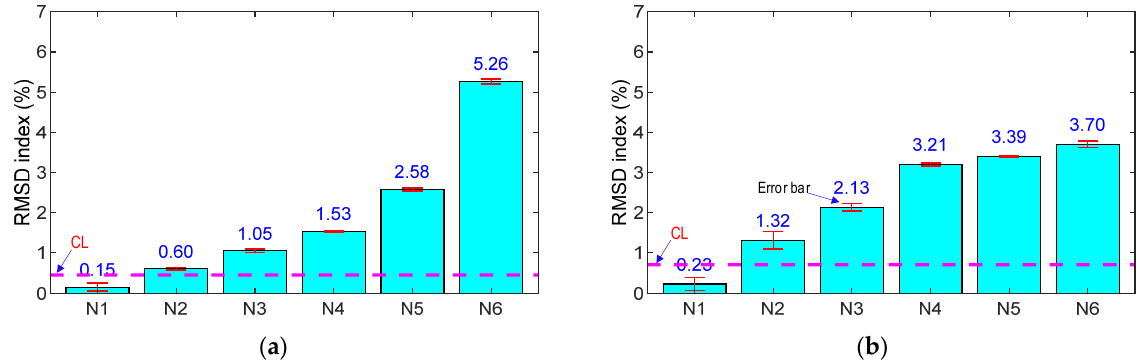
Figure 14. RMSD indices of experimental impedance signals of PZT sensors in the concrete sample under compression: ( a ) PZT-embedded smart rebar; ( b ) PZT-embedded smart aggregate.